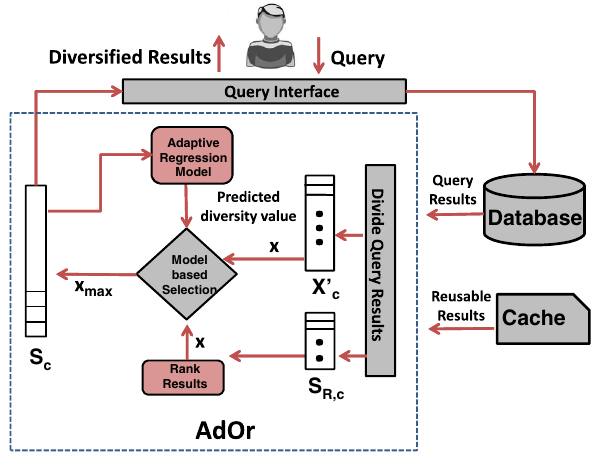
Fig. 4 Model-based diversification for clustered